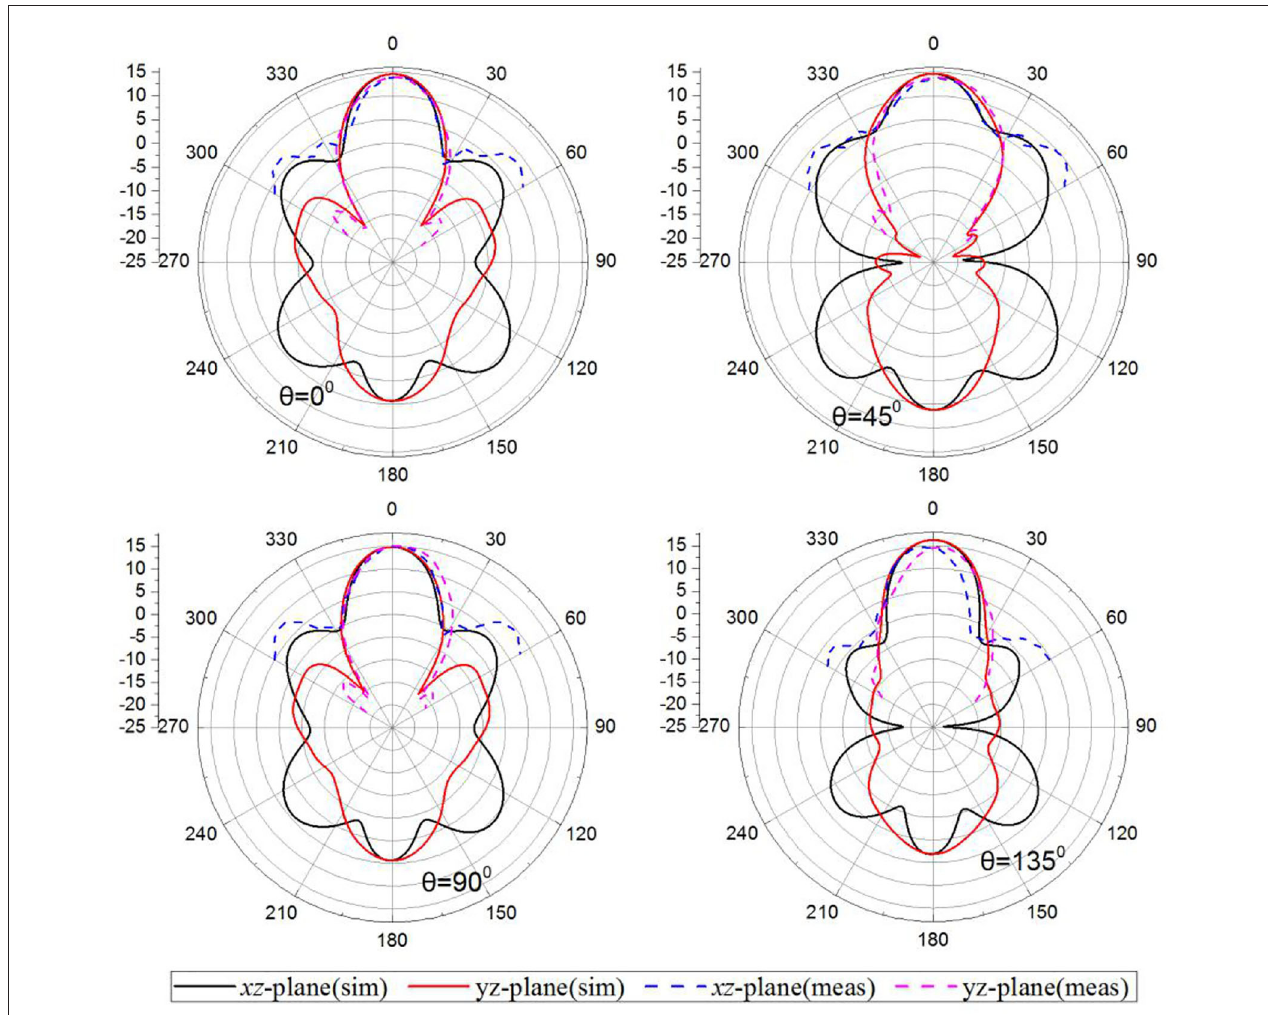
FIGURE 9 | Measured and simulated radiation patterns and gains with different rotation angle at 11